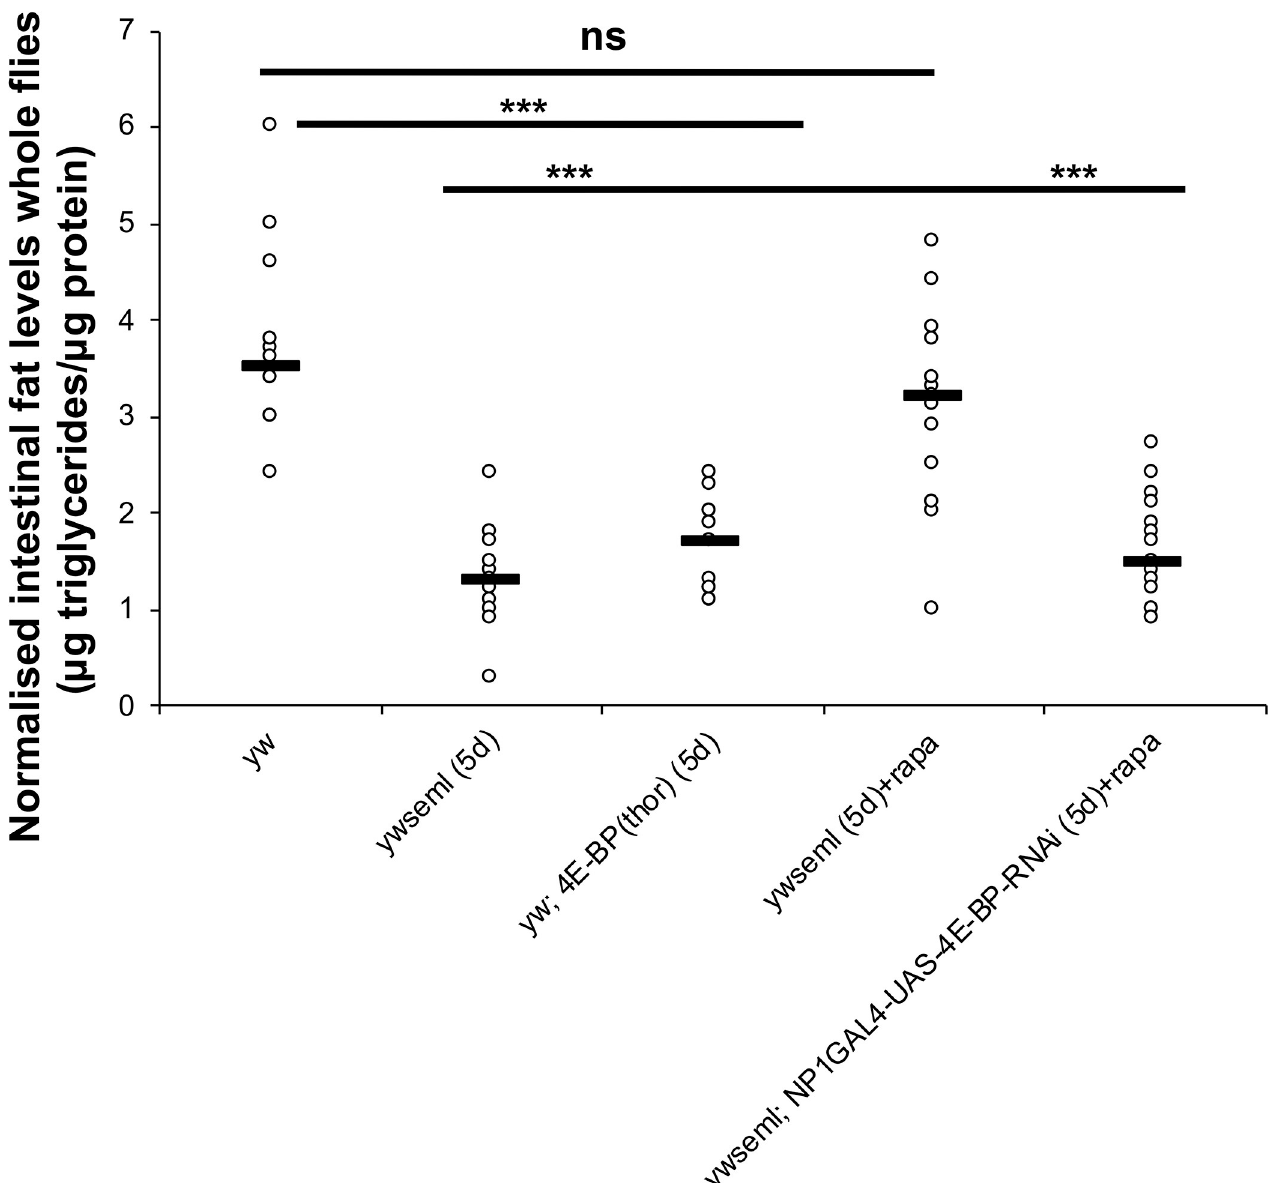
Fig 6. Loss of PGRP-SA increases intestinal fat levels. Loss of PGRP-SA increased intestinal triglyceride levels in 5-day old flies. This phenomenon was suppressed with pharmacological inhibition (rapamycin) or RNAi against TOR in ECs. This was dependent on 4EBP as yw seml; NP1 > 4E-BP RNAi treated with rapamycin had fat levels statistically indistinguishable from yw seml . N = 15/genotype/treatment a total of three independent experiments (each with n = 5/ genotype/treatment). Values of mutants and controls were statistically compared using student’s t-test ( ��� p < 0.001, all other comparisons non-significant except yw seml; NP1 > 4E-BP RNAi treated with rapamycin compared to yw , which has a p value < 0.001-comparison not shown in the